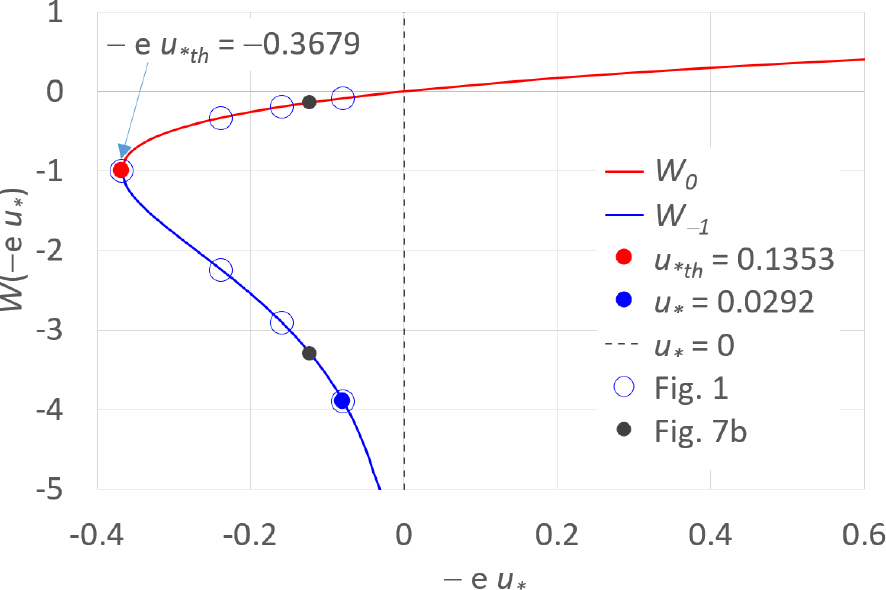
Figure 2. The two branches of the Lambert W function, W 0 and W − 1 . In the branch W − 1 , the Lambert W function values corresponding to the application performed later are indicated. The domain of the real x L solutions − e u *th ≤ − e u * ≤ 0 and the dots corresponding to the applications are also reported.